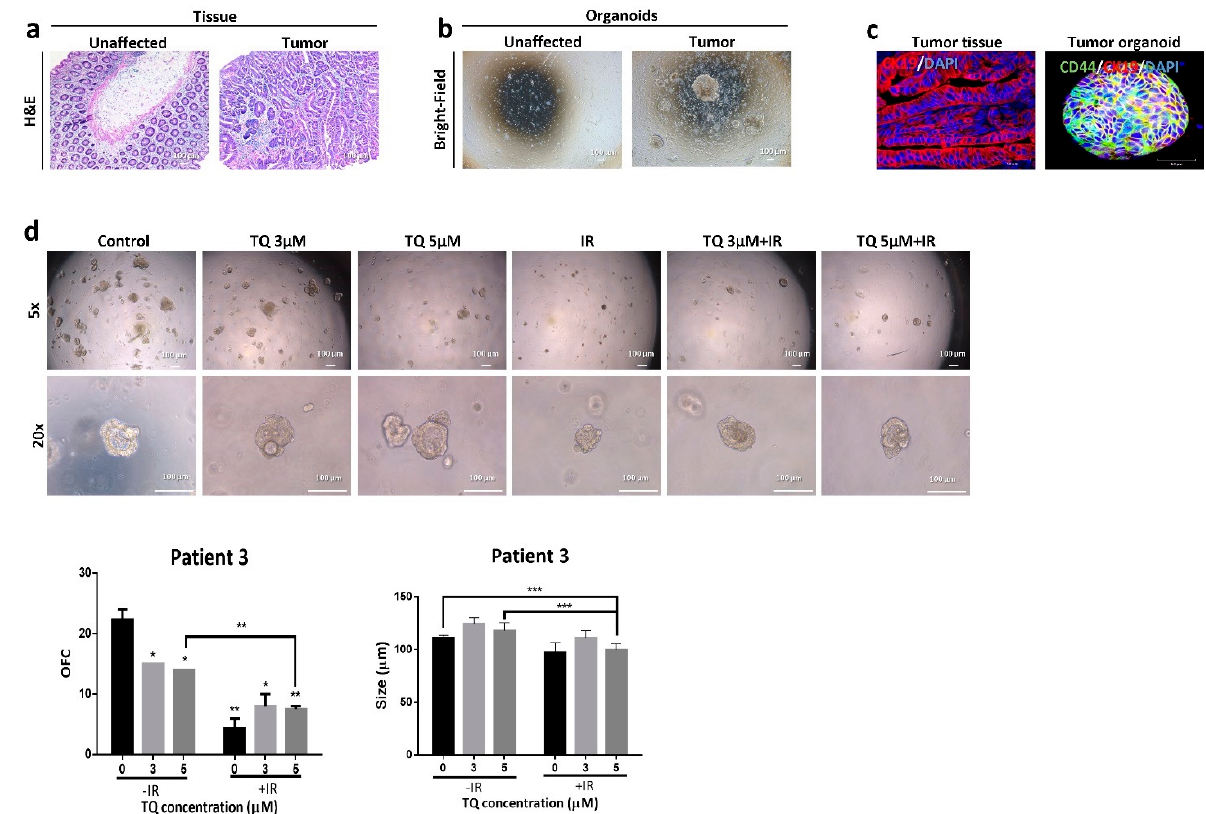
Figure 8. TQ and radiation reduce organoid-forming ability and size of patient 3-derived colon cancer organoids. ( a ) Representative images of H&E stain of unaffected and tumor colon tissue from patient 3. ( b ) Representative bright-field images of organoids derived from unaffected and tumor colon patient samples (patient 3). ( c ) Immunofluorescent images of tumor colon tissues and organoids stained for CD44 and CK19. Images were obtained using confocal microscopy. ( d ) Representative bright-field images of organoids derived from tumor colon patient 3 sample and treated with TQ (3 and 5 µM), radiation (2 Gy), or combinations. Fresh unaffected and tumor tissues were digested, and single cells were resuspended in 90% Growth Factor reduced Matrigel and 10% serum-free colon media and allowed to grow in serum-free colon media (without treatment). Generated organoids are referred to as G1 organoids. Organoids were propagated to G2 and treated with TQ, IR, or combination. OFC and size were calculated, and average values were reported as mean ± SEM (* p < 0.05, ** p < 0.01, *** p < 0.001). Images were visualized by Axiovert inverted microscope at 10× magnification. Scale bar for bright-field images is 100 µm and for immunofluorescent images is 50 µm.